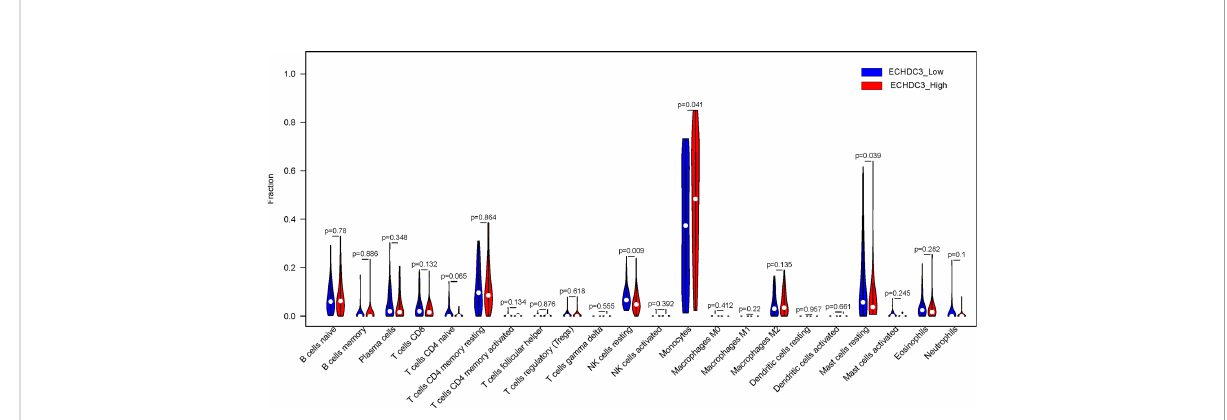
FIGURE 6 Different immune cells between ECHDC3 high and ECHDC3 low AML